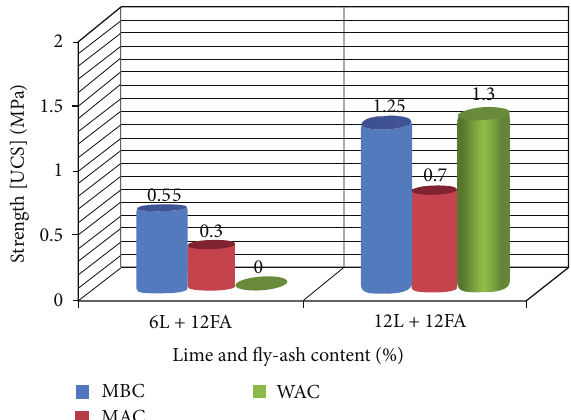
Figure 15: UCS of different lime and fly ash contents (dry durability conditions).